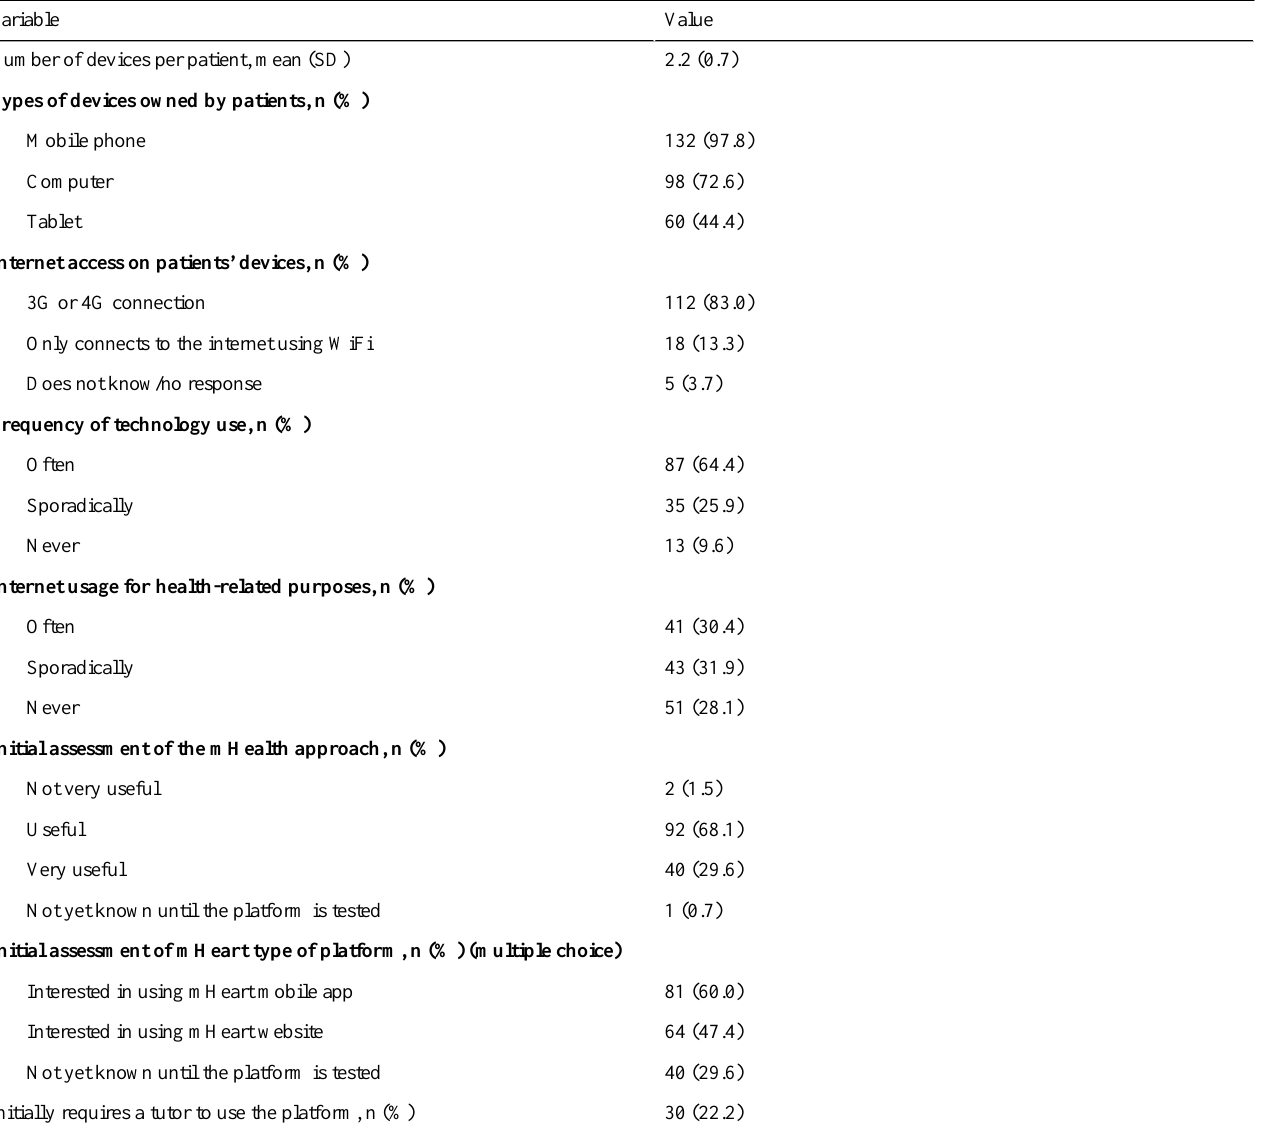
Table 2. Chronic heart transplant recipients’(>1.5 years from transplant) access to technology and willingness to use mobile health (mHealth) services